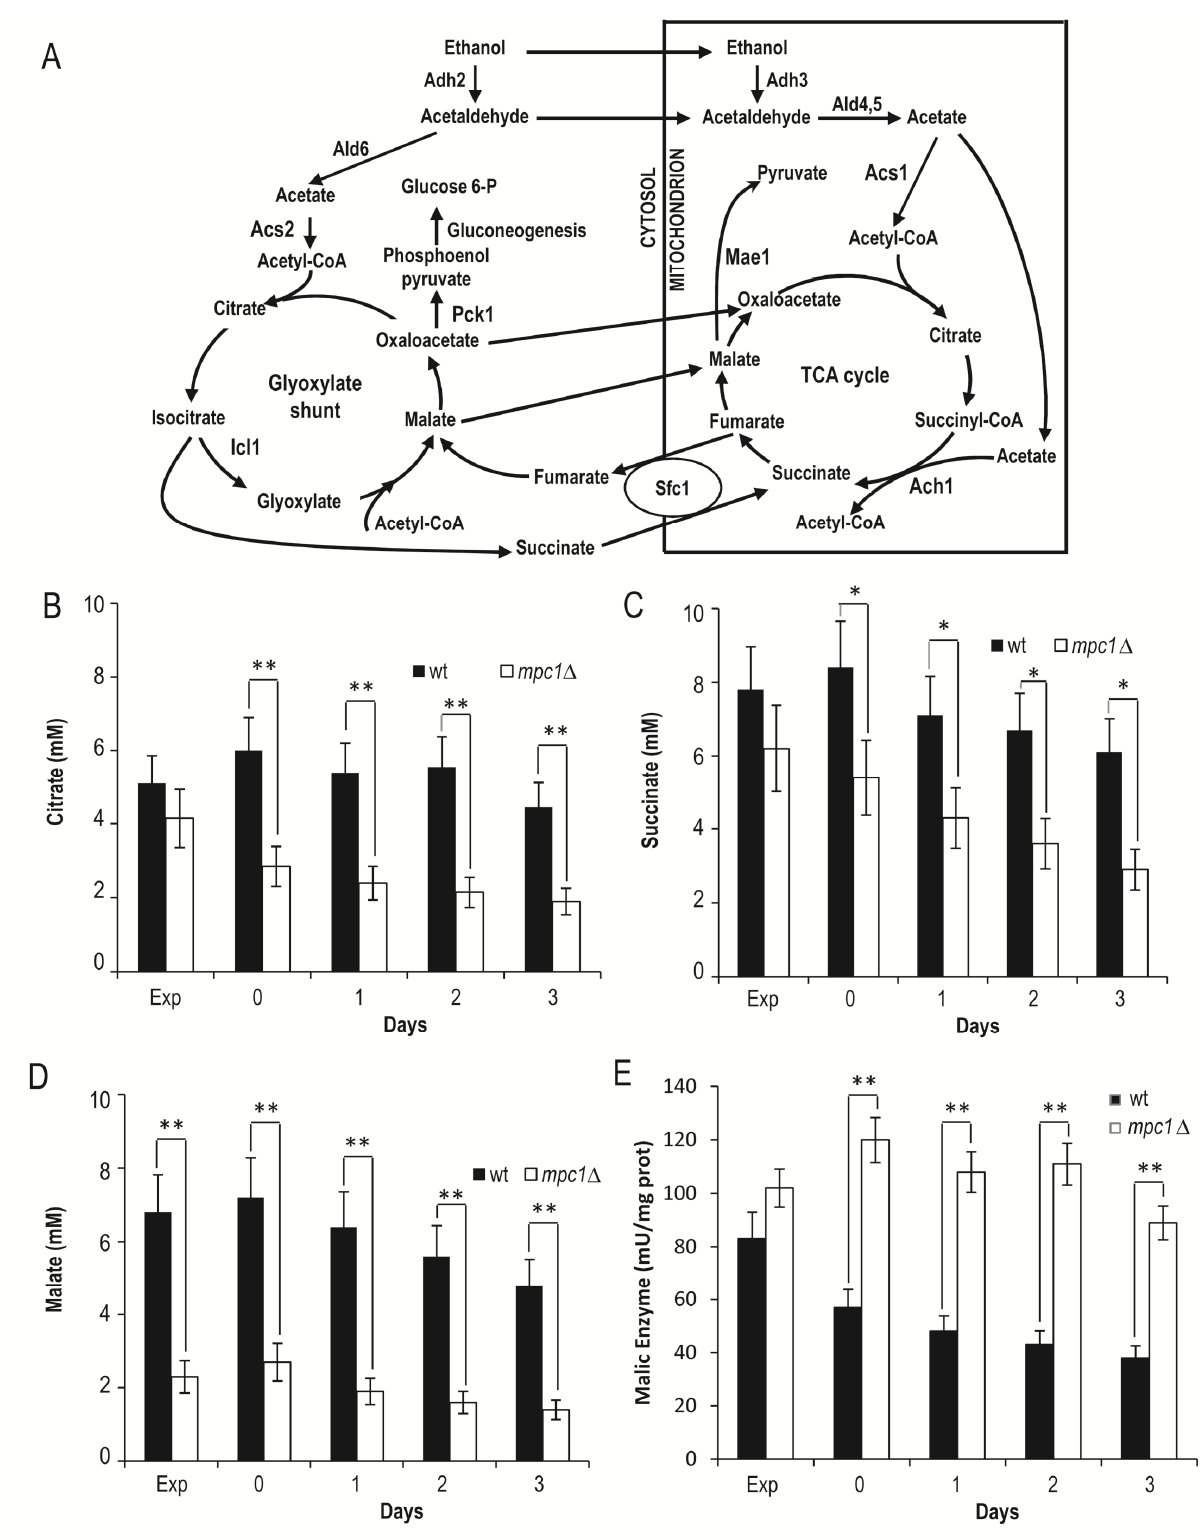
FIGURE 4: Lack of Mpc1 results in low levels of TCA cycle intermediates and enhanced malic enzyme activity. (A) Scheme of the TCA cycle and of the glyoxylate shunt. Ach1, acetyl-CoA hydrolase 1; Acs, acetyl-CoA synthase; Adh, alcohol dehydrogenase; Ald, aldehyde dehydro- genase; Icl1, isocitrate lyase 1; Mae1, malic enzyme; Pck1, phosphoenolpyruvate carboxykinase 1; Sfc1, succinate-fumarate carrier. Wt and mpc1 Δ cells were grown as in Figure 2 and at the indicated time points the concentrations of citrate (B) , succinate (C) and malate (D) were measured. The bar chart of malic enzyme activity (E) is also reported. Exp, exponential growth phase. Day 0, diauxic shift. Data refer to mean values determined in three independent experiments. SD is indicated. * P ≤ 0.05 and ** P ≤ OPEN ACCESS | www.microbialcell.com 397 Microbial Cell | December 2014 | Vol. 1 No. 12